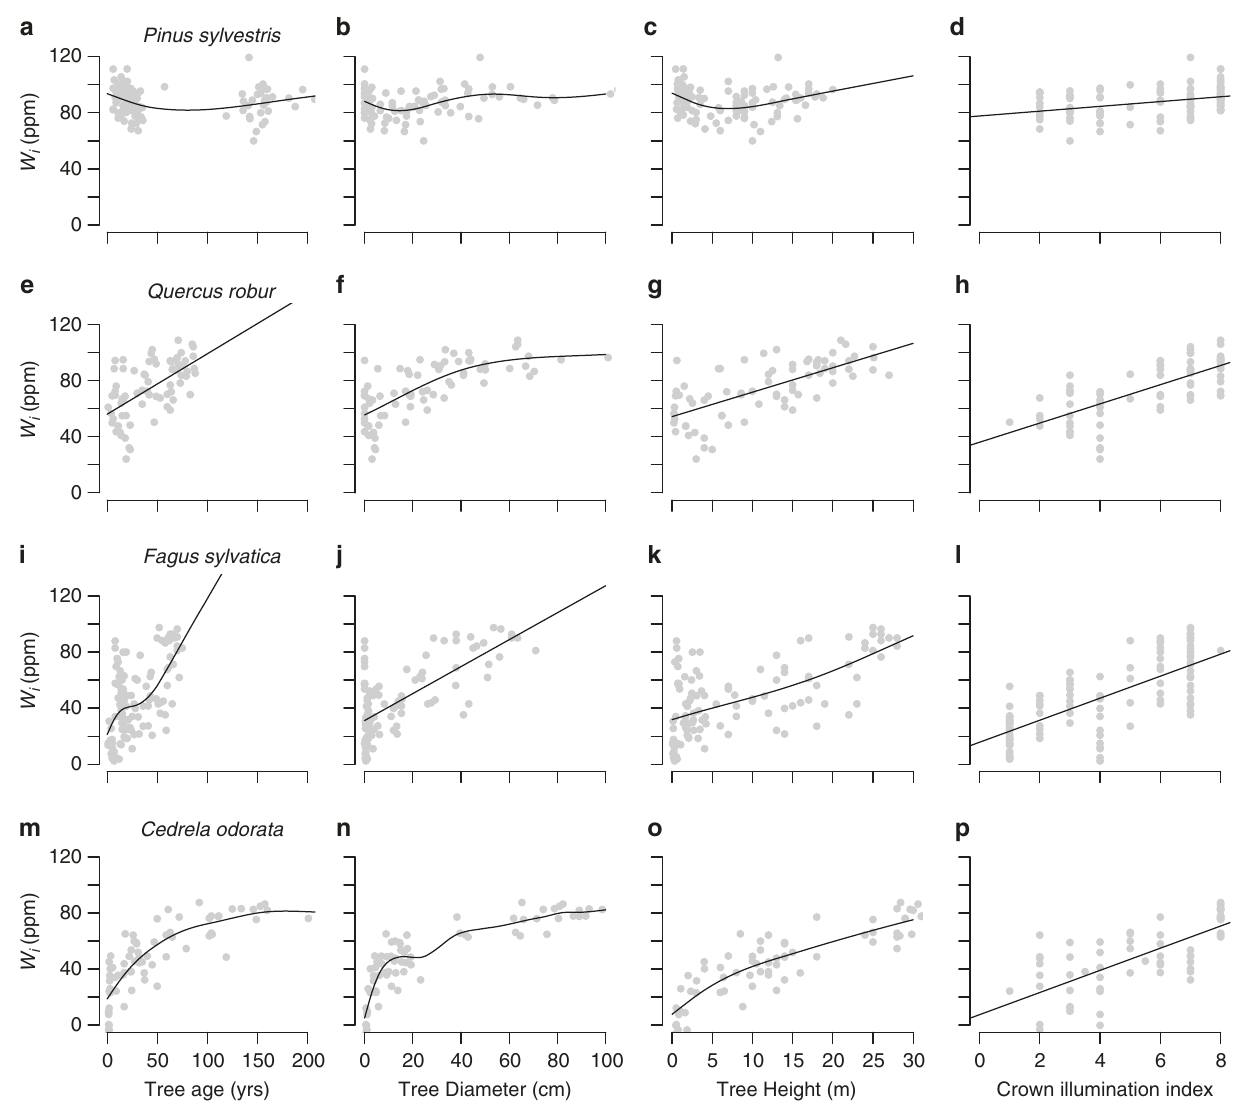
Fig. 2 Relationship between intrinsic water use ef fi ciency and tree age, diameter, height and crown illumination for the four species. a – d shows Pinus sylvestris , e – h shows Quercus robur , i – l shows Fagus sylvatica and m – p shows Cedrela odorata . Curves were determined using general additive mixed models ( GAMM ) from the gamm4 R package 74 . Crown illumination index values range from 1 for understory trees with no direct light, to 8 for trees with full crown exposure from above and side (see Methods section). Note that in this analysis (in contrast to data shown in Fig. 1) all trees were included even when lower than 1 m in height. Coef fi cients of determination (R-squared) and signi fi cance levels for the regressions are given in Table